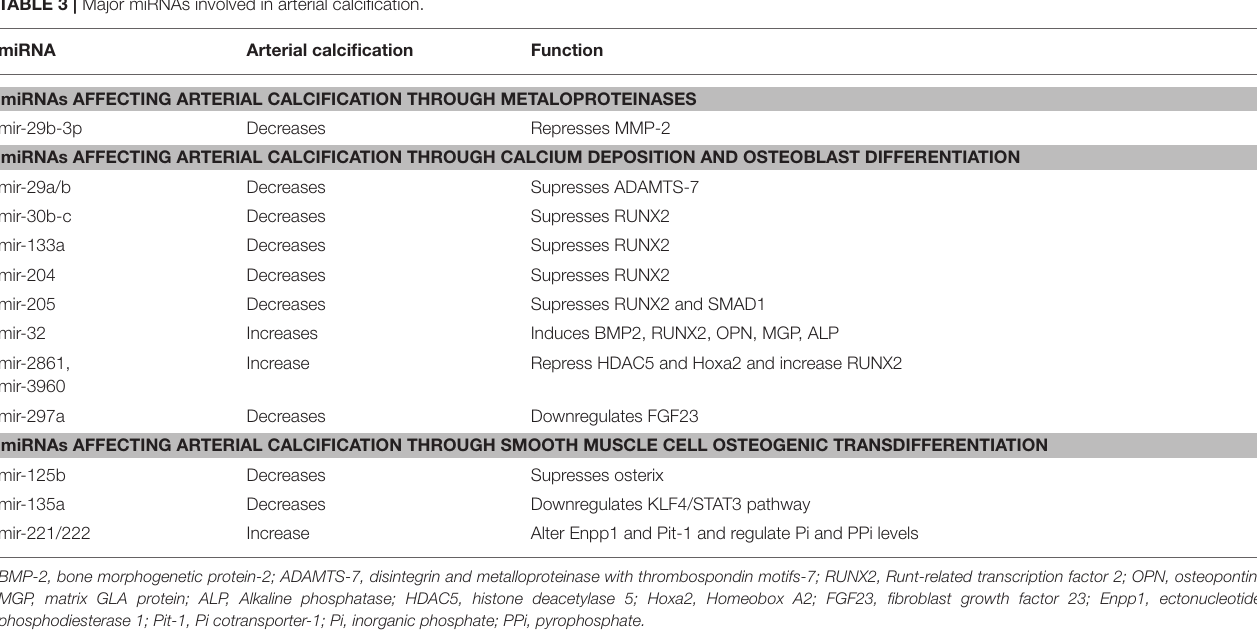
TABLE 3 | Major miRNAs involved in arterial calcification.